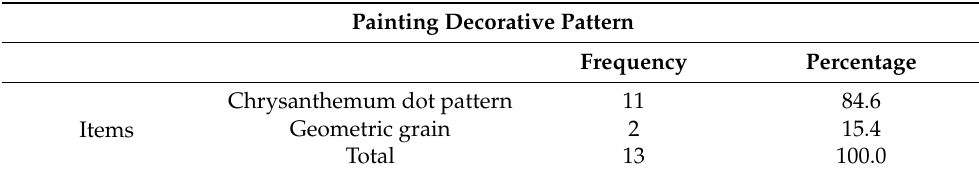
Table 5. Sample description and statistics of Xiaopi kiln ancient ceramic painting and decoration.